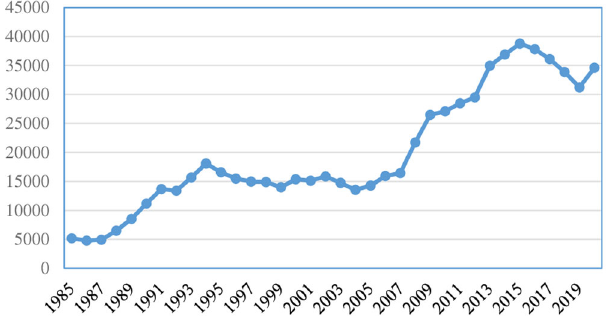
Fig. 1 RMO in million US dollars. Source: Word Bank (2021).